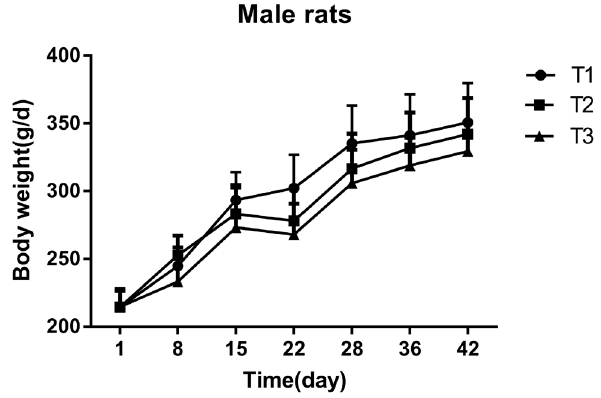
Figure 2. Effect of mulberry leaves on the body weight of male rats. The x- and y-axes indicate time and body weight, respectively. T1 = control group; T2 = low dose group; T3 = high dose group. Error bars are standard error of the